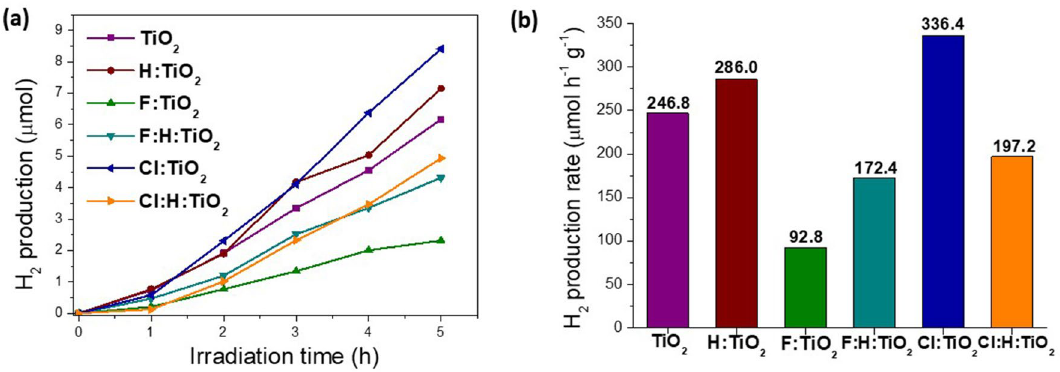
Figure 6. Photo-catalytic hydrogen production plots ( a ) and average rate ( b ) of different